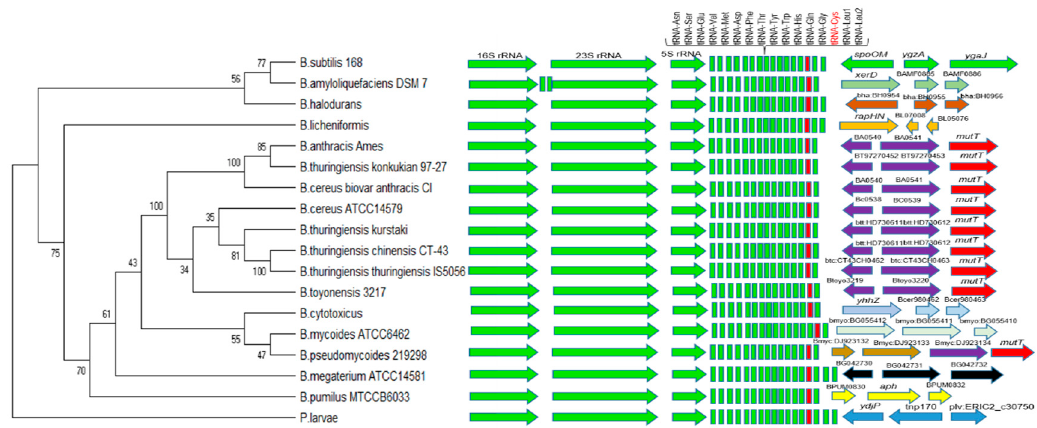
Figure 1. Distribution and copy number of tRNA genes in genomes of Bacillus spp. The tRNA genes were mapped and extracted using the tRNAscan-SE program. From predicted genes, tRNA counts per iso-acceptor were obtained and cluster analyses were done using the software R package, version 3.0.2. The Color Key refers to numbers of copies of the tRNA genes.